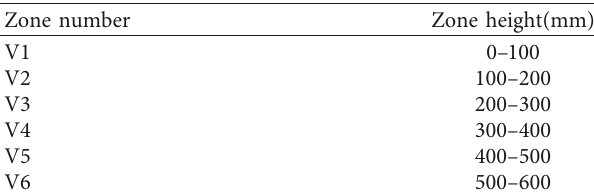
Table 11: Vertical zone